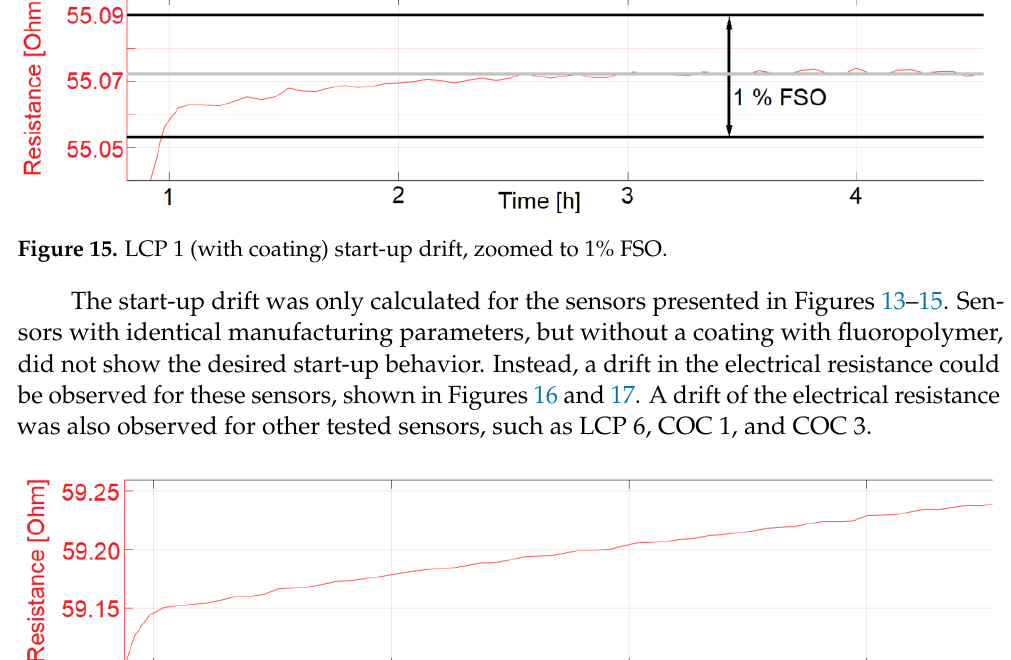
Figure 14. LCP 7 (with coating) start-up drift, zoomed to 1% FSO.